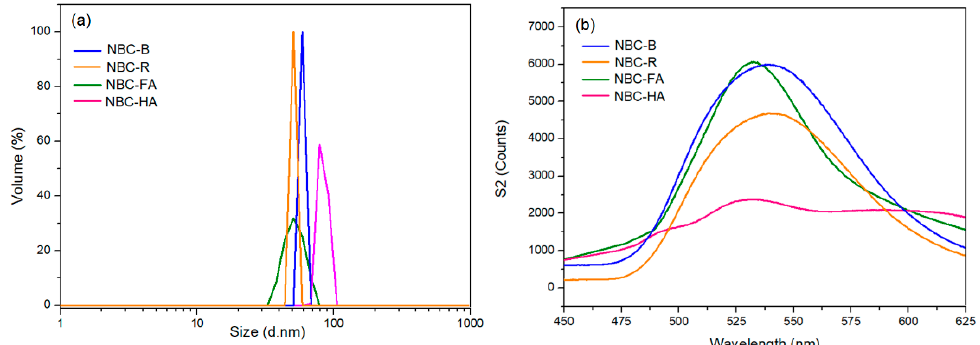
Figure 7. ( a ) Volume-weighted size distribution of NBC-B, NBC-FA, NBC-R and NBC-HA dispersions in deionized water; ( b ) PL spectra of NBC-B, NBC-FA, NBC-R and NBC-HA in water, at the excitation wavelength of 360 nm. The samples were tested at the concentration of 100 ng/mL.